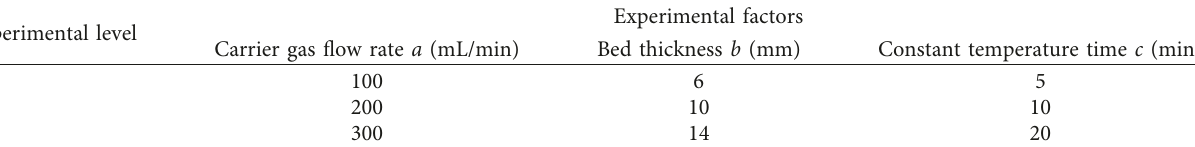
Table 1: Process optimization factors in pyrolysis process.